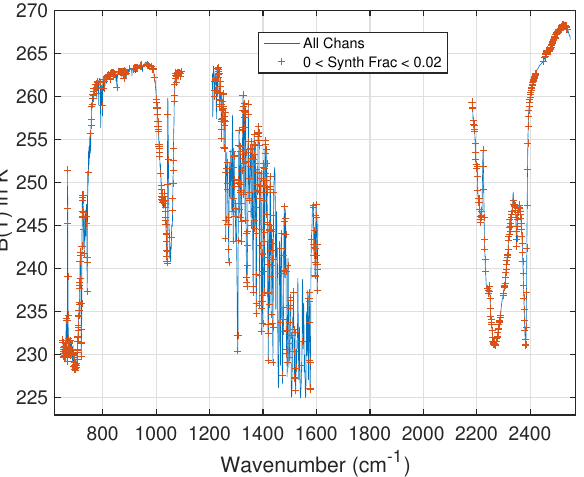
Figure 7. Sample CHIRP spectrum with channels containing less than a 0.02 synthetic fraction (from AIRS L1C). In generally low synthetic fraction denotes high quality